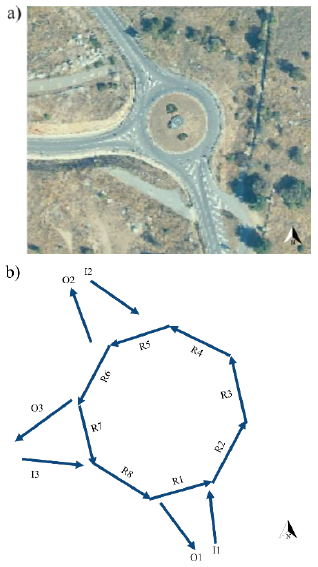
Figure 6. (a) Top view of the case study and (b) bearing vectors Figure 7 shows the driver’s vision in the horizontal plane (blue arrows) during each season, referring to the vector 5 of the roundabout. The number of hours where sun rays have incidence on the driver’s vision in the horizontal plane increase from winter solstice to summer solstice (passing through the spring equinox). Solar altitude also increases, therefore sun rays are no longer incident on the vertical plane of vision when it is reached a certain height. During summer solstice sun rays are not incident in several hours of daylight due to the high altitude of the Sun, although they are indecent in numerous hours of daylight in the horizontal plane of vision.